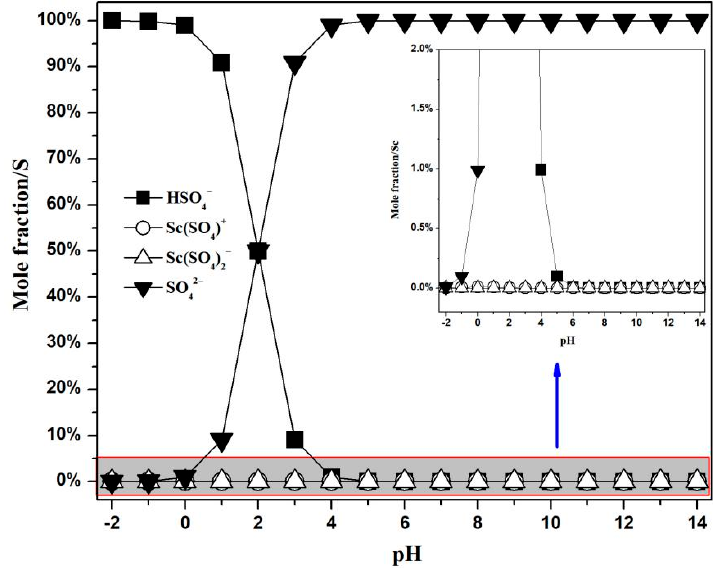
Figure 2. Mole fraction diagram of ions containing sulfur in the Sc-S-H 2 O system at 298 K with various